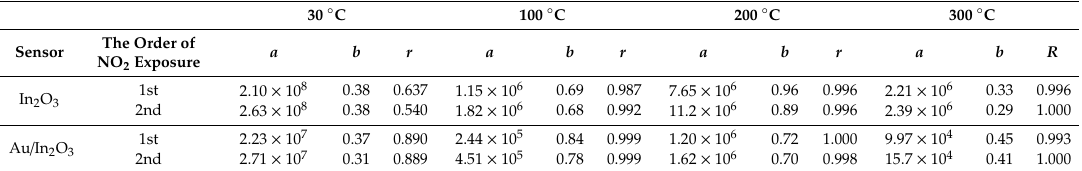
Table 2. Comparison of a and b values and correlation coe ffi cients ( r ) of the In 2 O 3 and Au / In 2 O 3 sensors in wet air (70%RH at 25 ◦ C) at 30, 100, 200, and 300 ◦